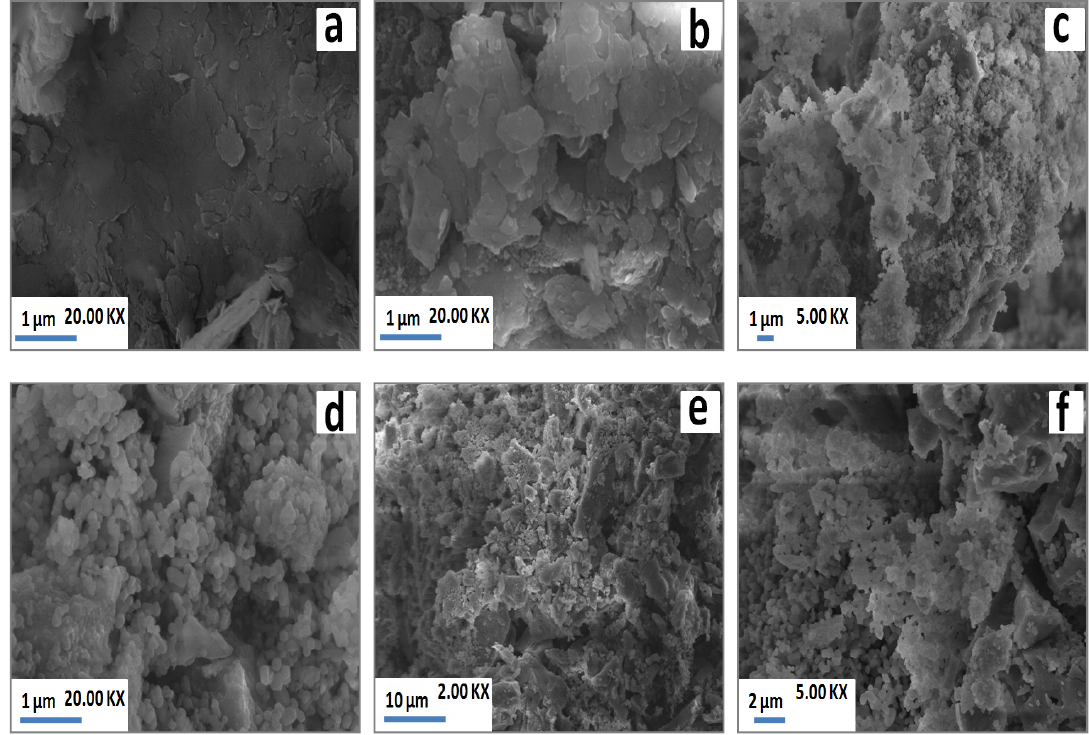
Figure 5. SEM micrographs of PS-SC (20 wt. % of SC) blends heated at 900 °C ( a ) and 1100 °C ( b–f ).